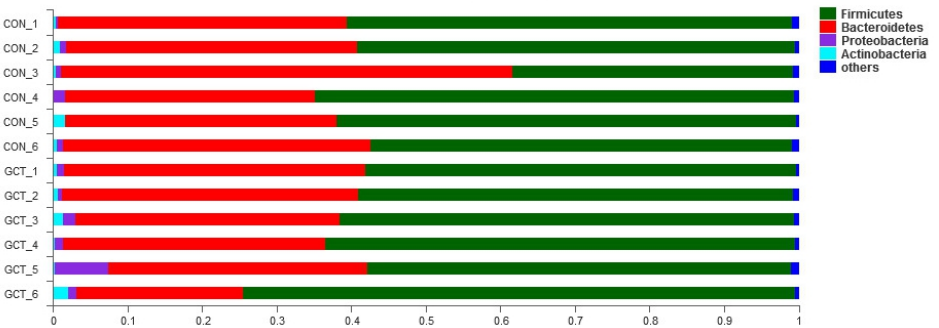
Figure 1. Distribution of piglets’ cecal microflora at the phylum level. The stacked histogram shows the relative abundance of each cecal sample at the phylum level. CON, ZnO diet; GCT, hydrolyzed Chinese gallnut tannic acid diet.